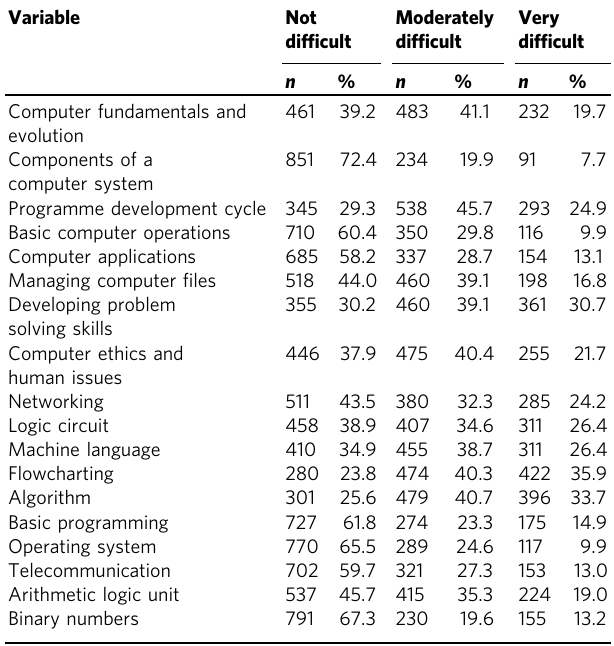
Table 1 Level of dif fi culty in the study of computer studies in African secondary